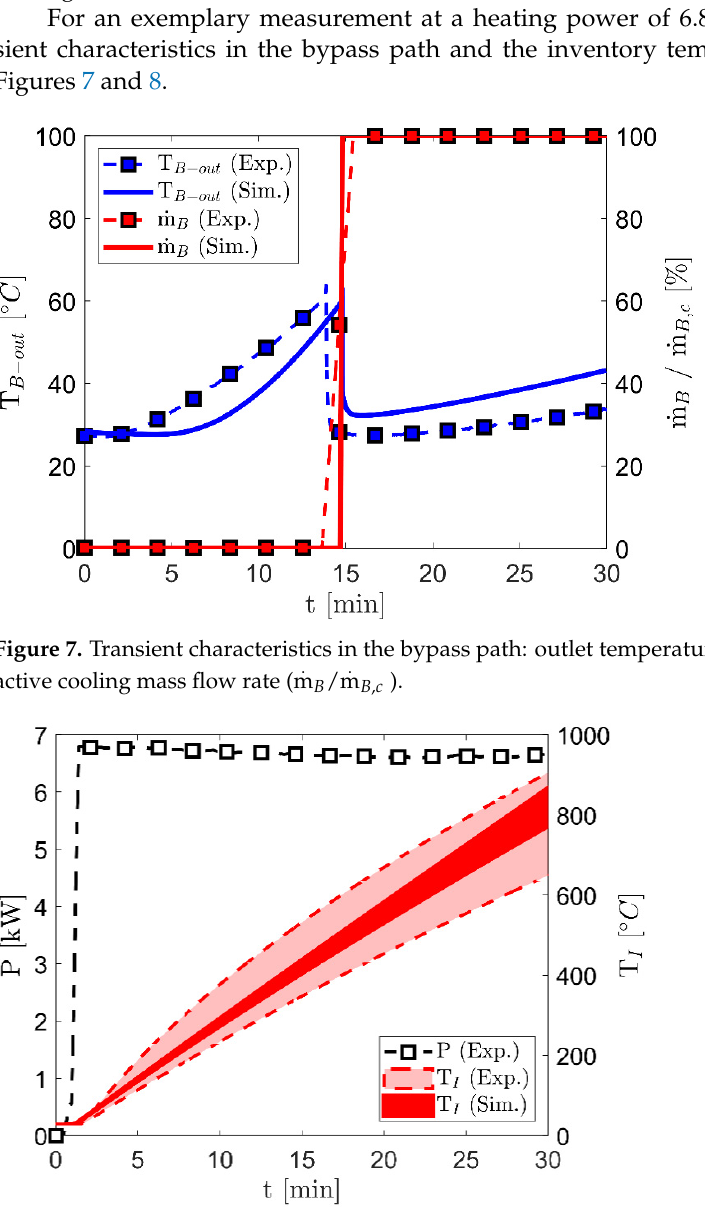
Figure 8. Transient temperatures in the honeycombs ( T (cid:3010) ) and electric heating power (P).